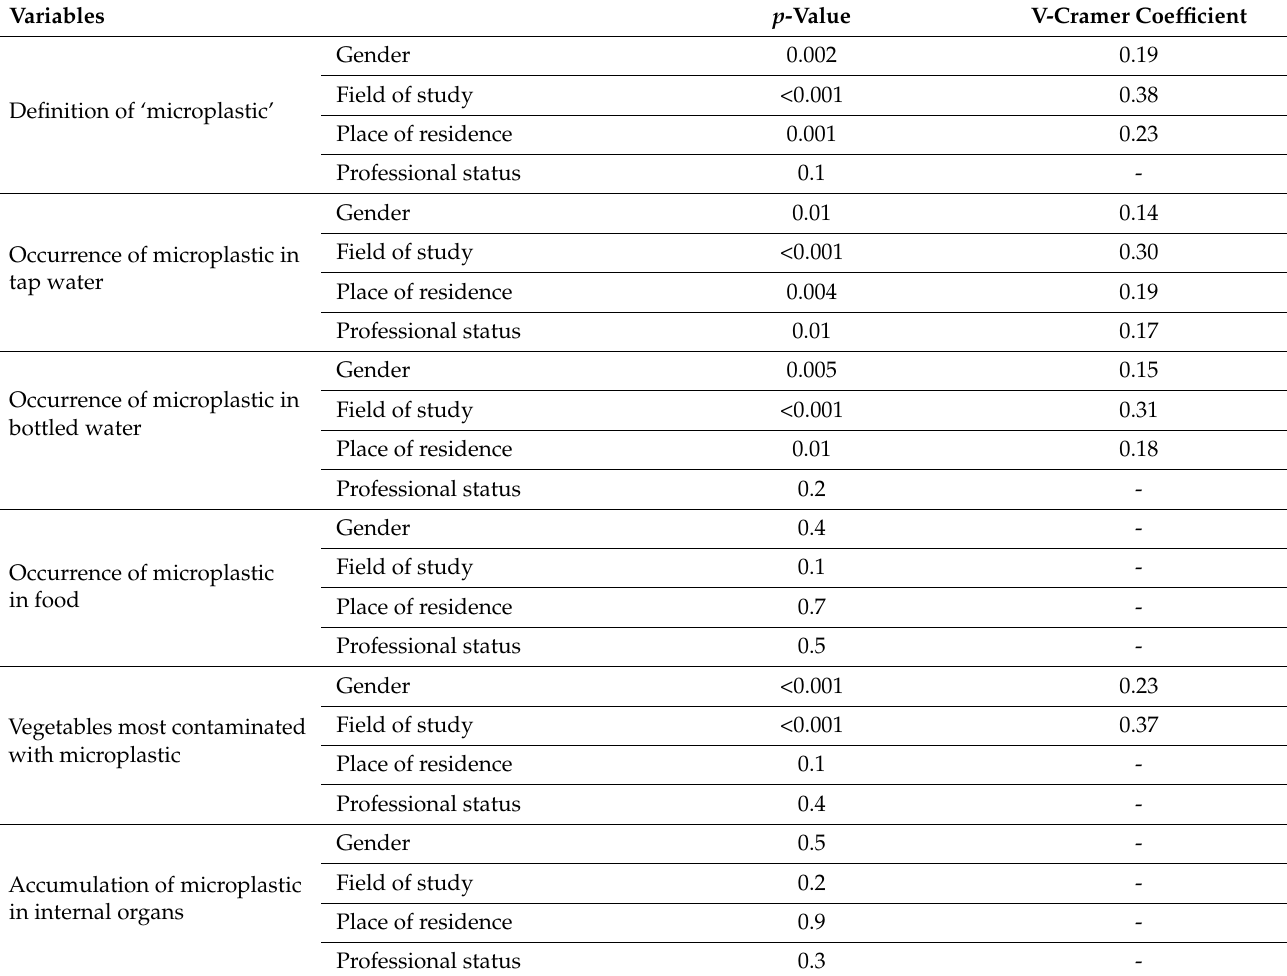
Table 4. Results of independence tests between knowledge of the topic of microplastics and data characterizing the study